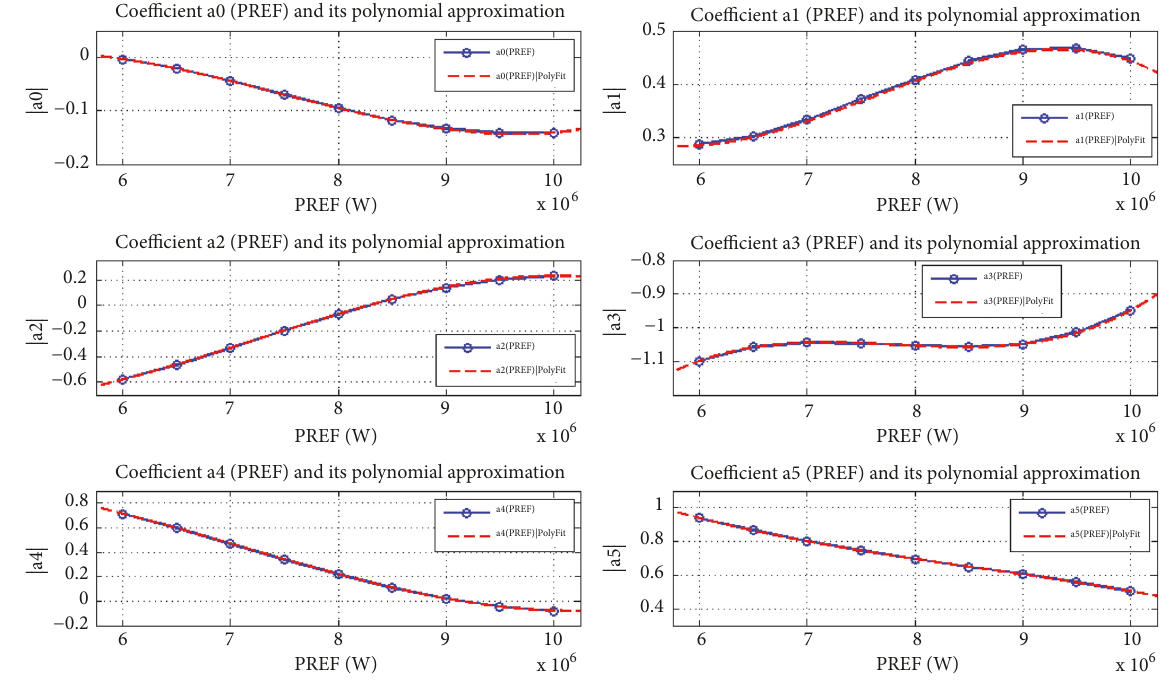
Figure 12: Design of gain scheduling controller: piecewise continuous functions of numerator of 𝑔 푐 (𝑧) and its polynomial approximation ( 3 rd ) in subresonant CCM.